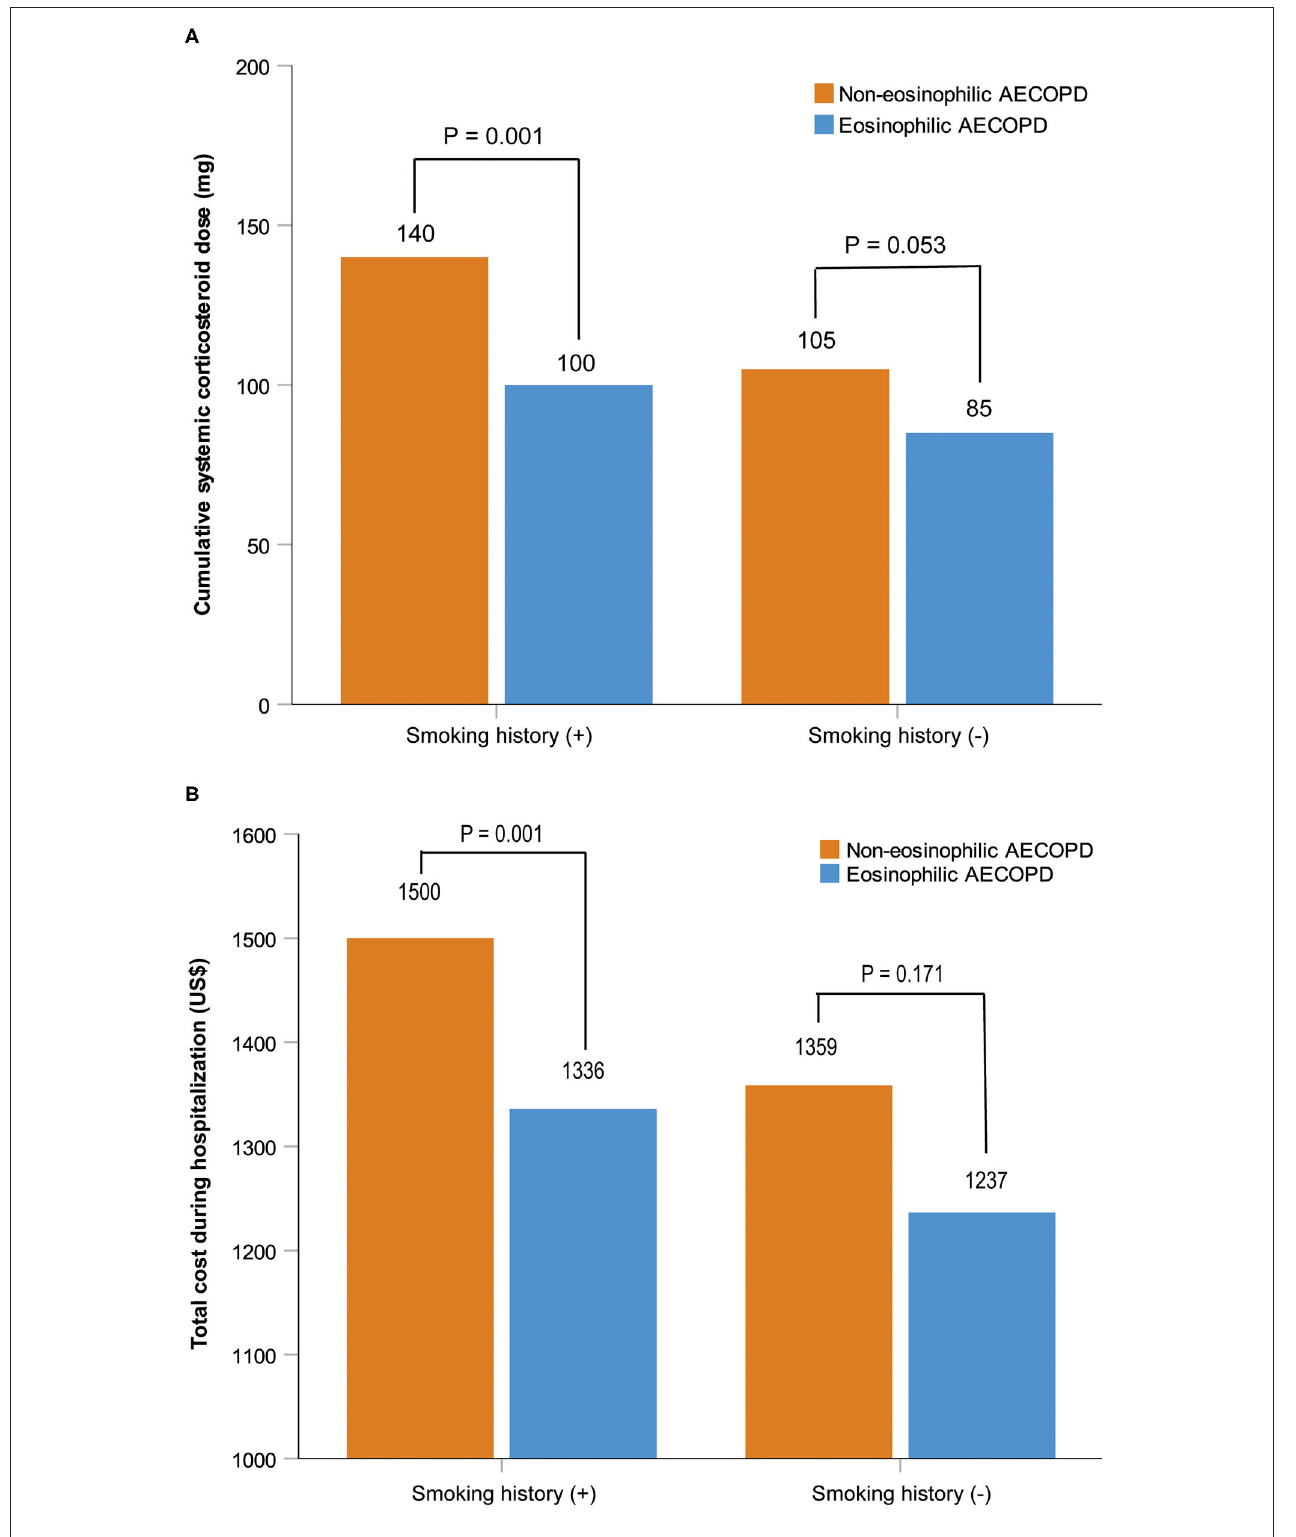
FIGURE 3 | Cumulative systemic corticosteroid dose and total cost during hospitalization in patients with or without smoking history after matching. Data are presented as median. AECOPD, acute exacerbations of chronic obstructive pulmonary disease.